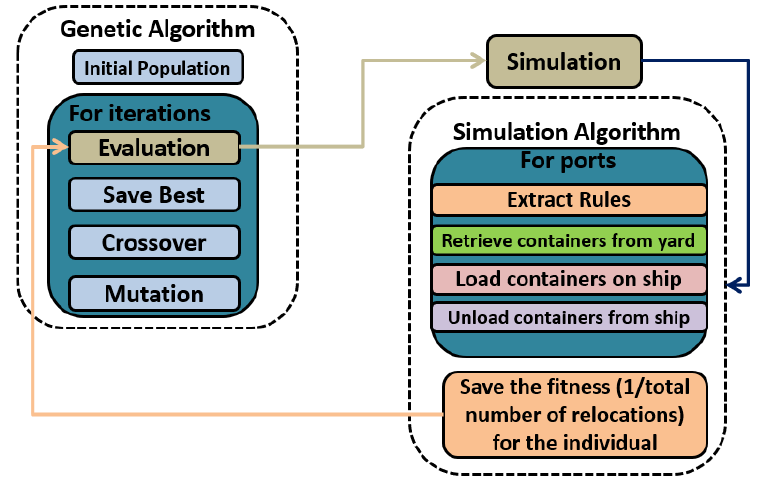
Figure 10. Representation of the proposed